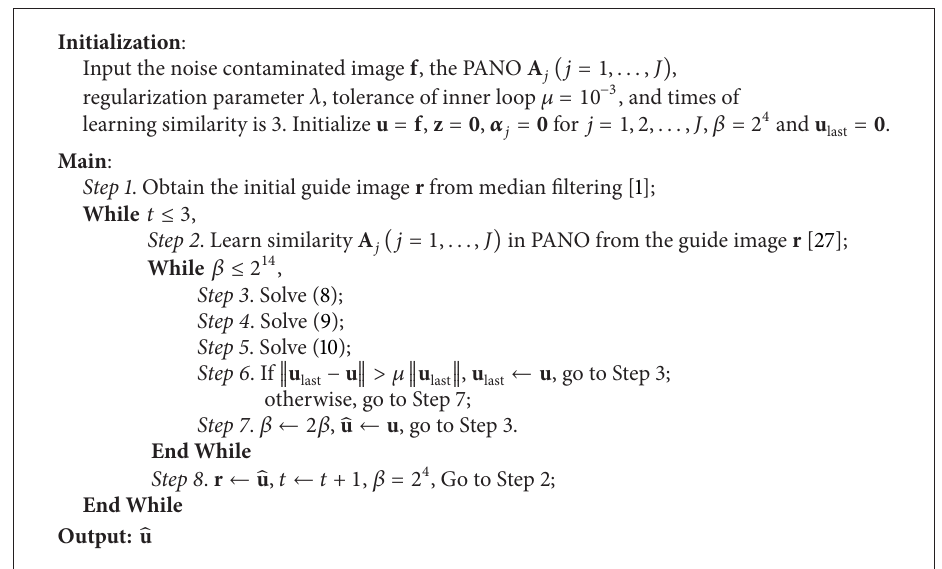
Algorithm 1: Remove impulse noise using